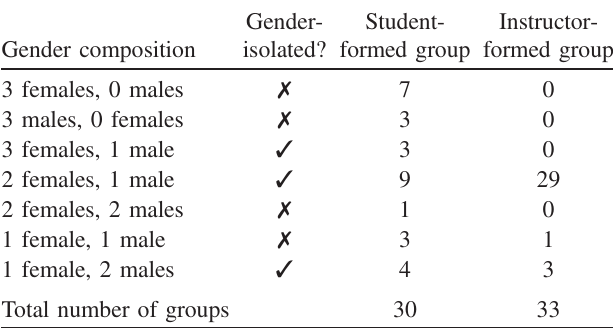
TABLE I. Summary of gender composition for the two differ- ent types of groups. Groups greater than 2 members that have a single female or a single male are defined as “ gender isolated ”